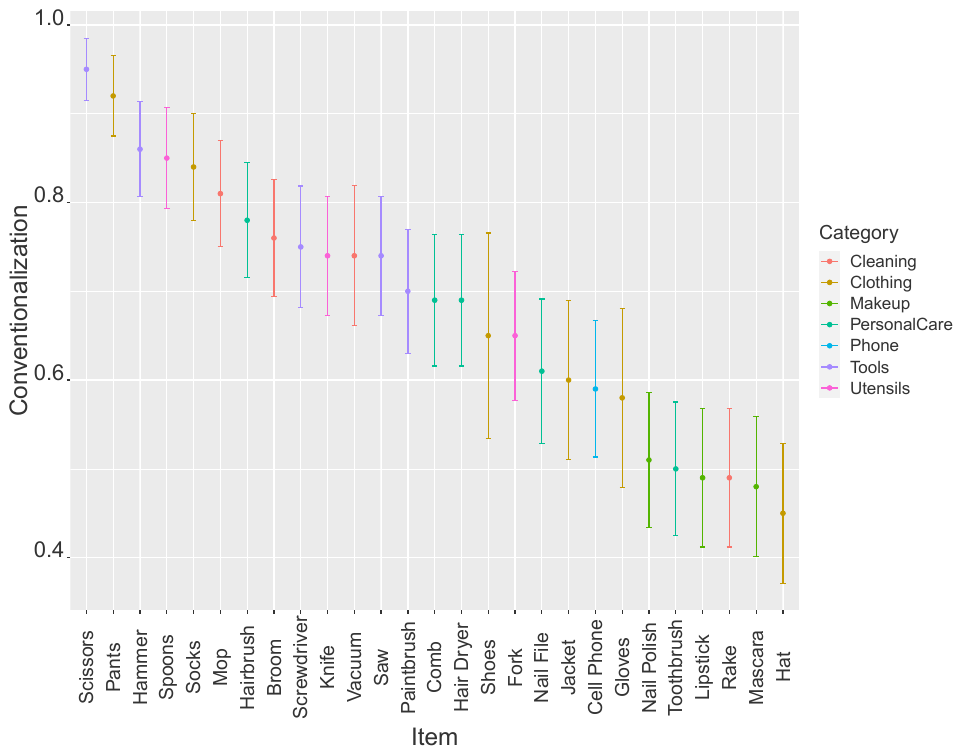
Figure 2. Items ordered by overall conventionality of handshape type across groups. Each category of object is shown in a different color. Dots represent the percentage of participants who used the most common handshape type for each item (Handling or Object). Lines represent standard error.